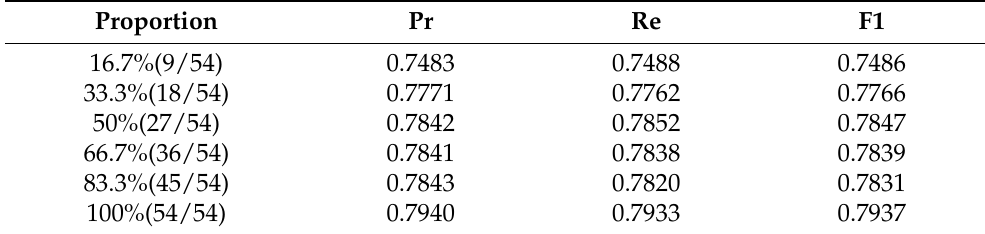
Table 15. The performance of the LightEyes when varying the number of training samples on the hard exudate segmentation task (IDRiD dataset).